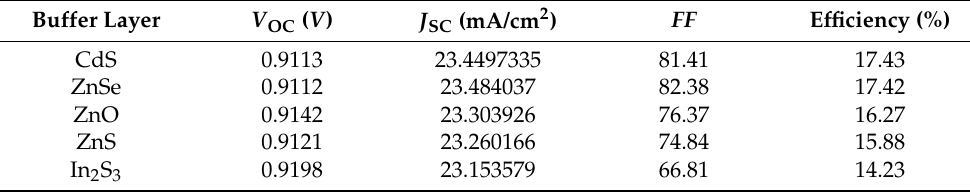
Table 4. Effectiveness of the buffer material (donor) on J – V